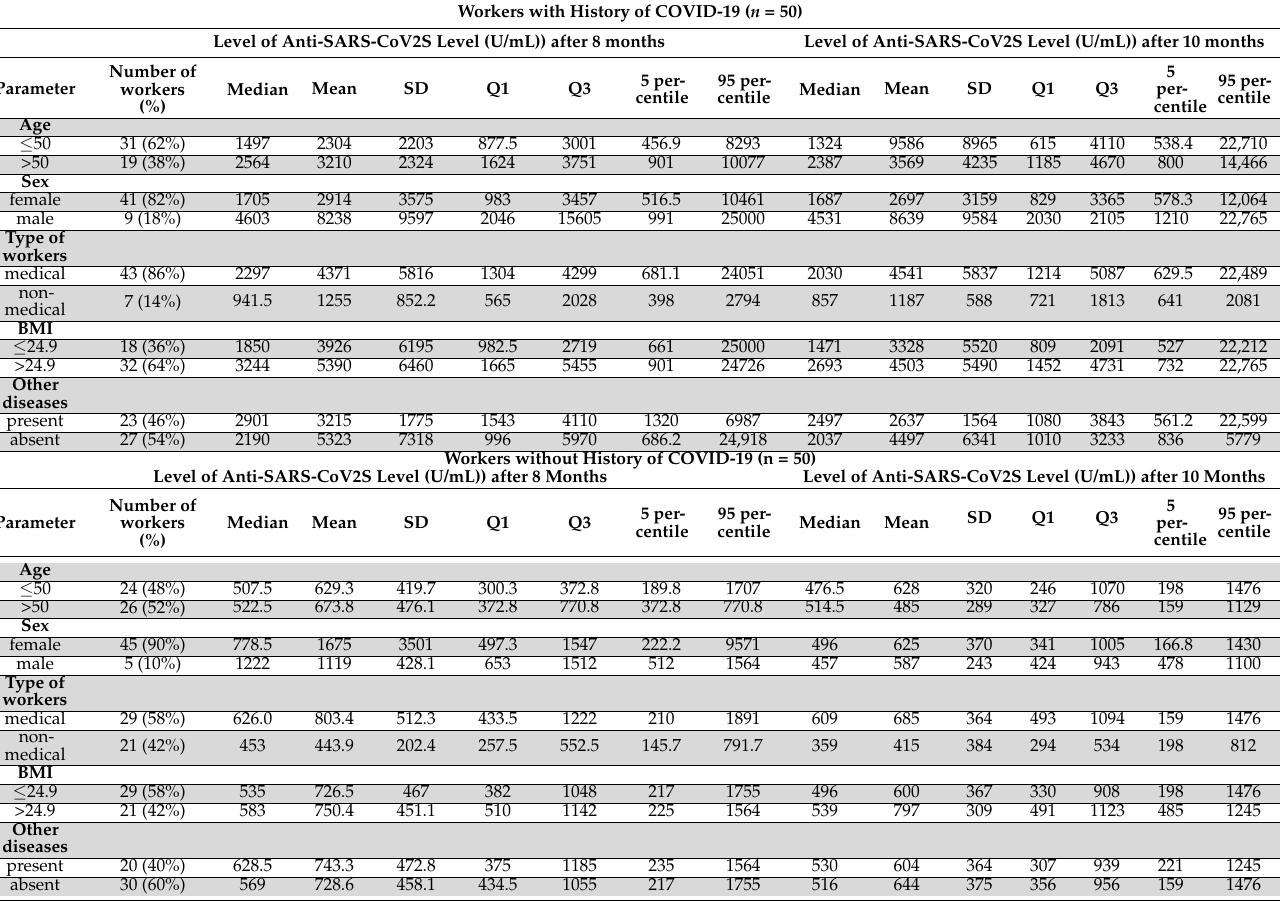
Table 1. Characteristic of study